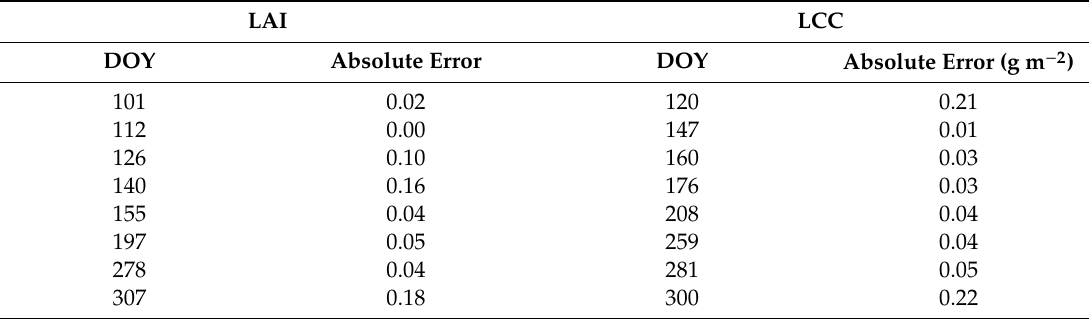
Figure 3. Time series of mean and interpolated LAI ( a ) and LCC ( b ) values calculated over all ESUs. Error bars and dashed lines represent ± 1 standard deviation. Table 4. Leave-one-out cross-validation results indicating the absolute error associated with interpolated LAI and LCC values on each sampling date (i.e., the error that would occur if that observation were not used in function fitting).